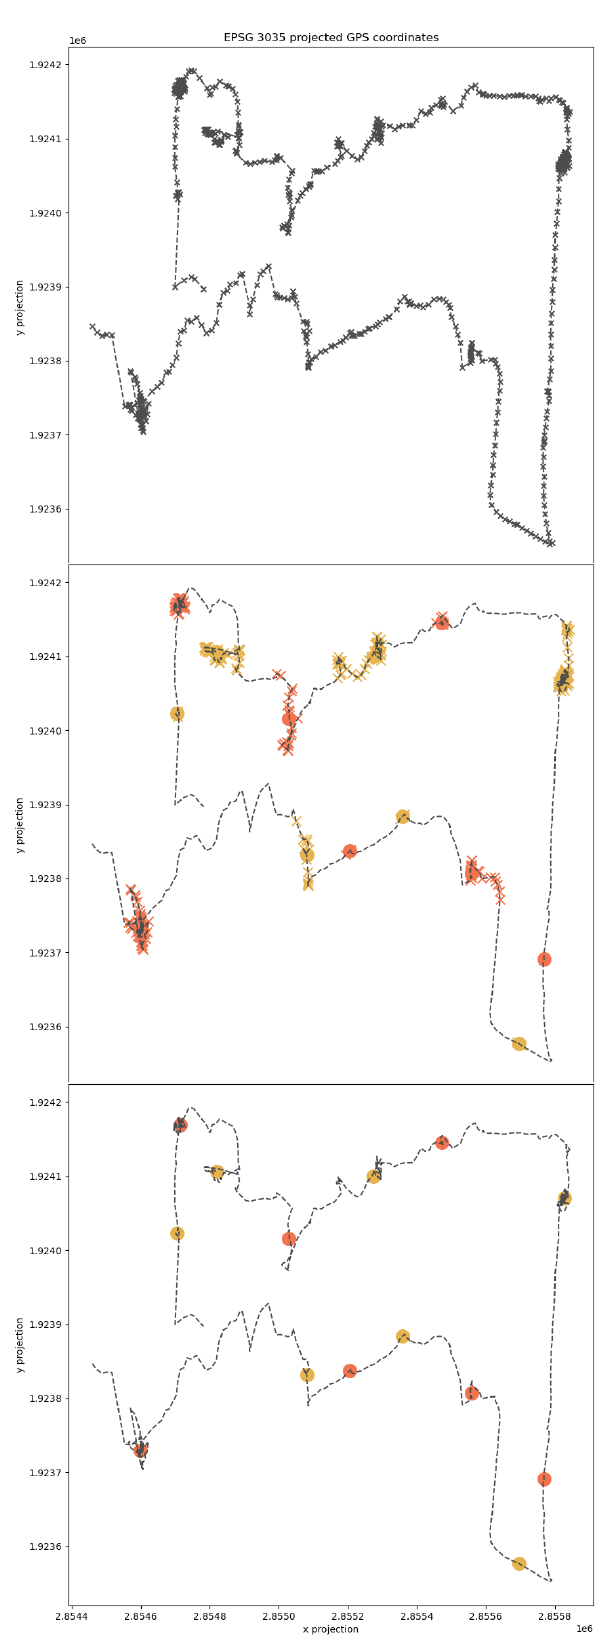
Figure 1. Example of the stop classification process. All three plots show the same trajectory, a city walk of about four hours. Top: raw samples; mid-section: all stop-classified samples; bottom: isolated stop